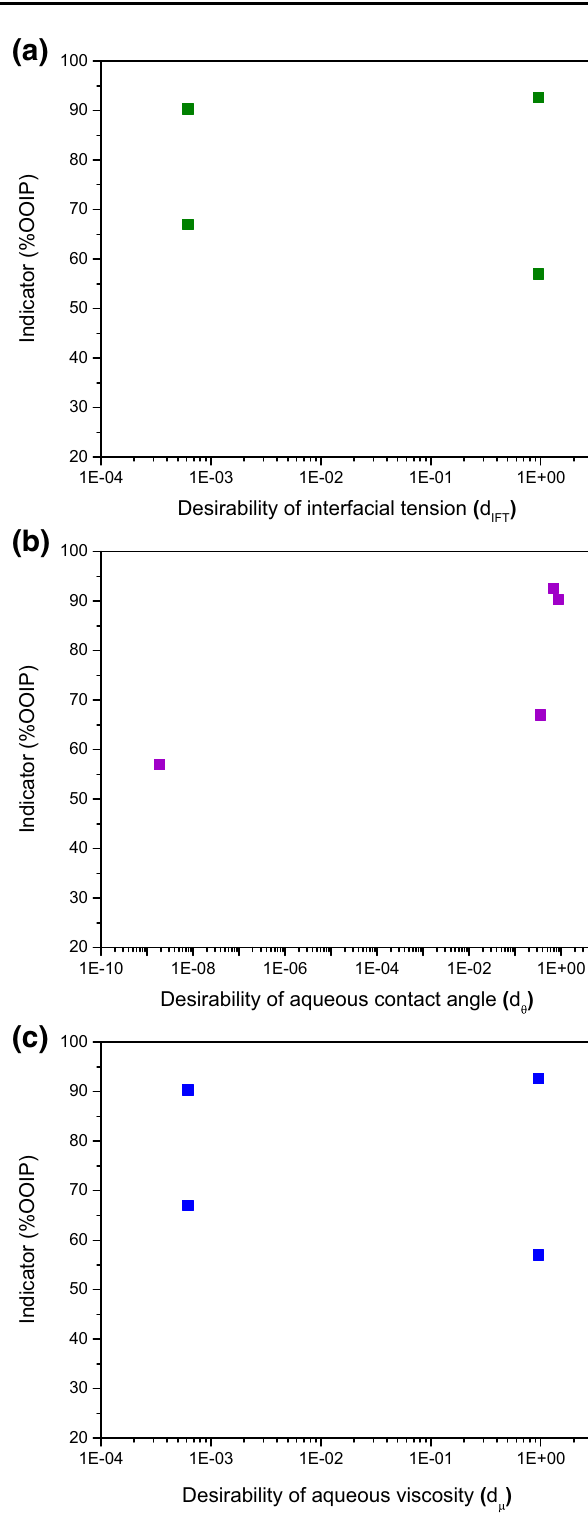
Fig. 2 Individual desirability ( d i ) of a interfacial tension, b aqueous contact angle and c aqueous viscosity to the oil recovery (%OOIP) as an assessing